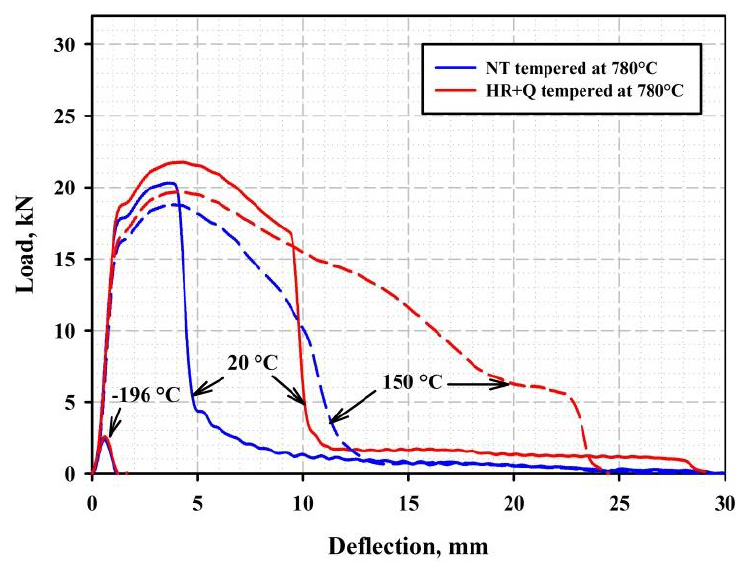
Figure 14. Load–deflection curves of the NT and HR+Q samples tempered at 780 °C and tested at −196, 20 and 150 °C.